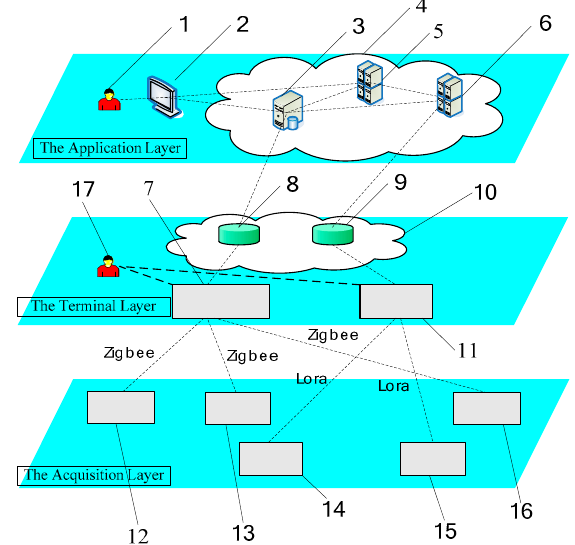
Figure 2. Detecting and wireless communication system of the SAW sensor array. 1—Decision Making User; 2—Display Platform; 3—Database Server; 4—Cloud Computing Platform; 5—Application